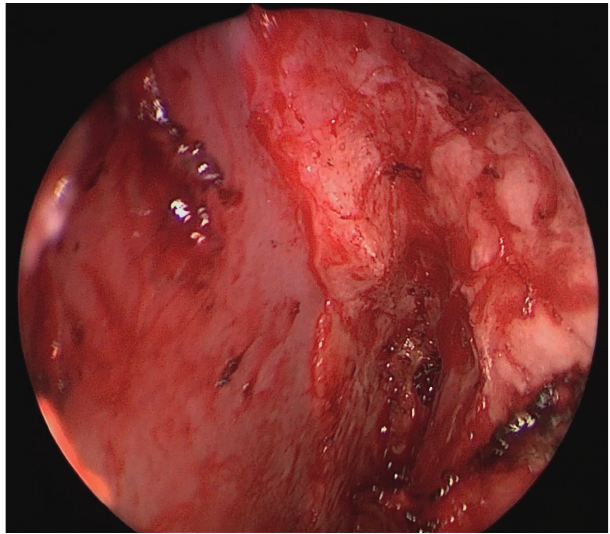
Figure 4. Endoscopic view of the superior ‘vault’ region of the left nasal cavity